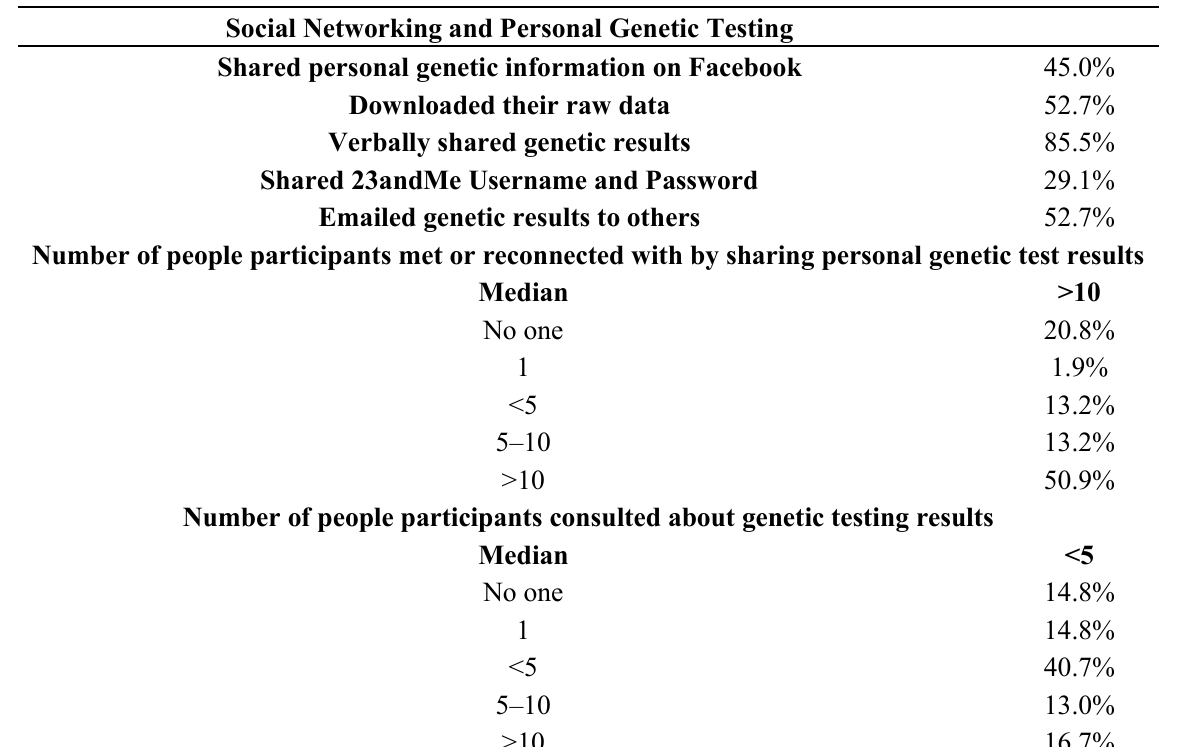
Table 2. Sharing behaviors among